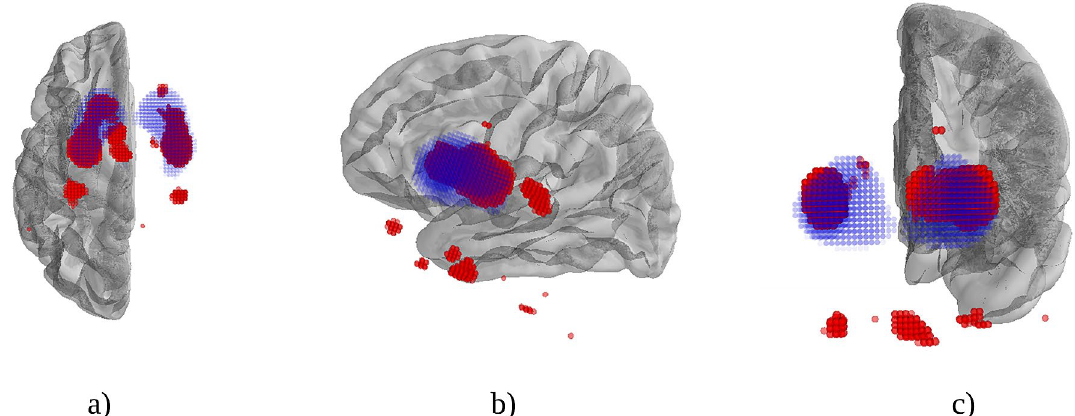
Figure 5. Example of informative voxels outside (red points) the ROIs areas (blue points) in a patient showing ( a ) axial, ( b ) sagittal and ( c ) coronal views.